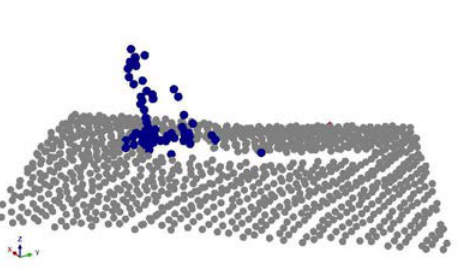
Figure 3. Example of rock bolt point cloud